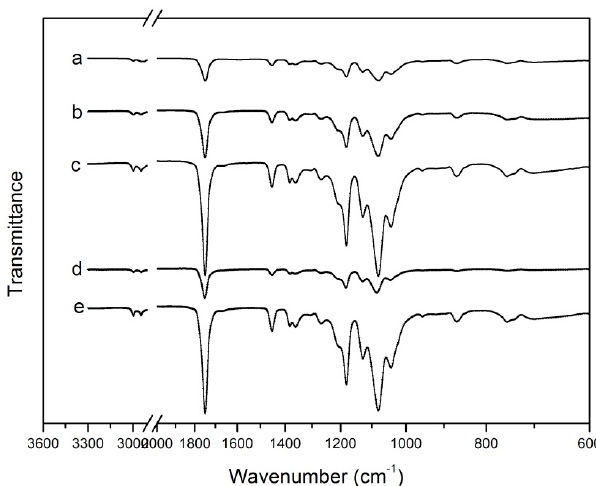
Figure 4. The FTIR spectra of: (a) PLA, (b) PLA/Ti1%, (c) PLA/Ti5%, (d) PLA/Ti1%/Ag, and (e) PLA/Ti5%/Ag.